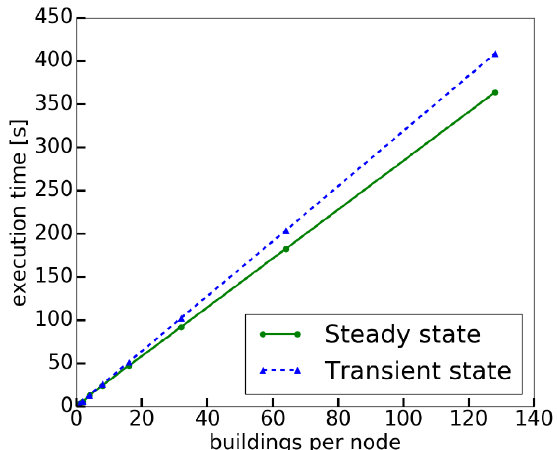
Figure 10. Execution time of the Power Prediction algorithm with respect to the number of buildings per